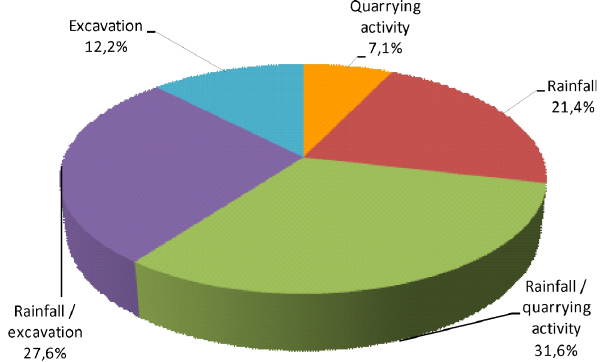
Fig. 6. Duration vs. intensity plot for landslide-producing storms that occurred in the Campania region (after Calcaterra et al., 2000, Fig. 7. Triggering factors of the 1868–1985 landslides at Naples (revisited and updated after Calcaterra et al.,